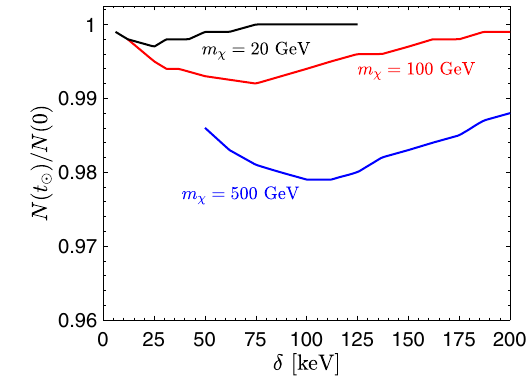
Fig. 10 Ratio between the total number of particles, after the distribu- tion has evolved for a solar lifetime, and the initial number of particles. Results for different dark matter masses are shown: m χ = 20 GeV (black), m χ = 100 GeV (red) and m χ = 500 GeV